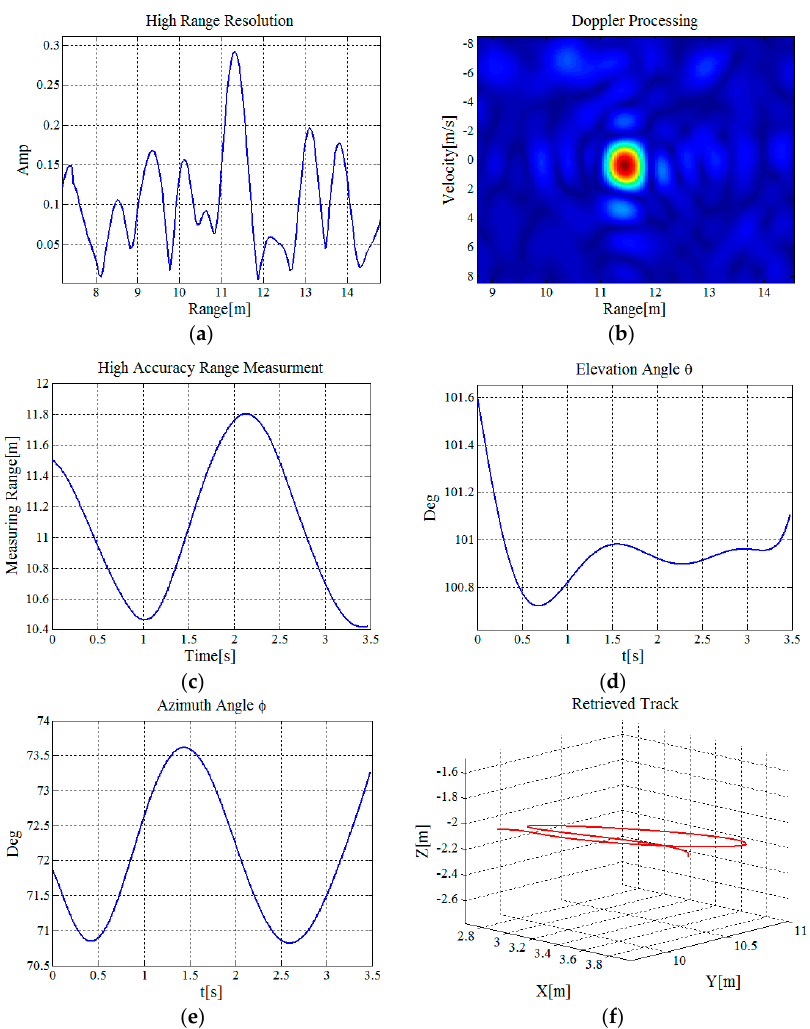
Figure 8. Experimental results: ( a ) Amplitude curve of the high resolution synthesizing result; ( b ) Doppler coherent processing result; ( c ) high accuracy range measurement result with carrier phase;